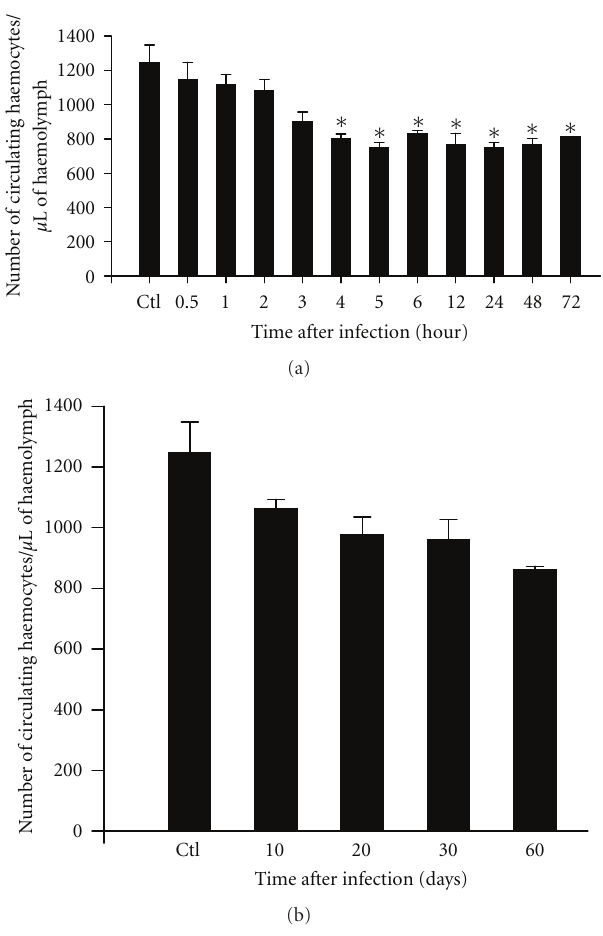
Figure 1: Mean number of circulating haemocytes/ µ L of haemo- lymph in three snails from each experimental group. Ctl— Bio- mphalaria glabrata free from infection with A. vasorum and B. glabrata exposed to 1,000 first-stage larvae of A. vasorum at di ff erent time of infection. Data are presented as mean number ± standard deviation of circulating haemocyte subpopulations. ( ∗ ) Represents significant di ff erences ( P < 0 . 05) in the number of haemocytes of each point of infection to control group.